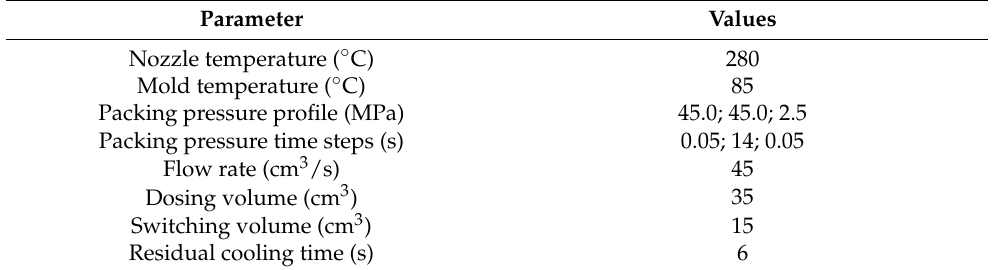
Table 1. Optimum parameters for the performed injection molding manufacturing process.